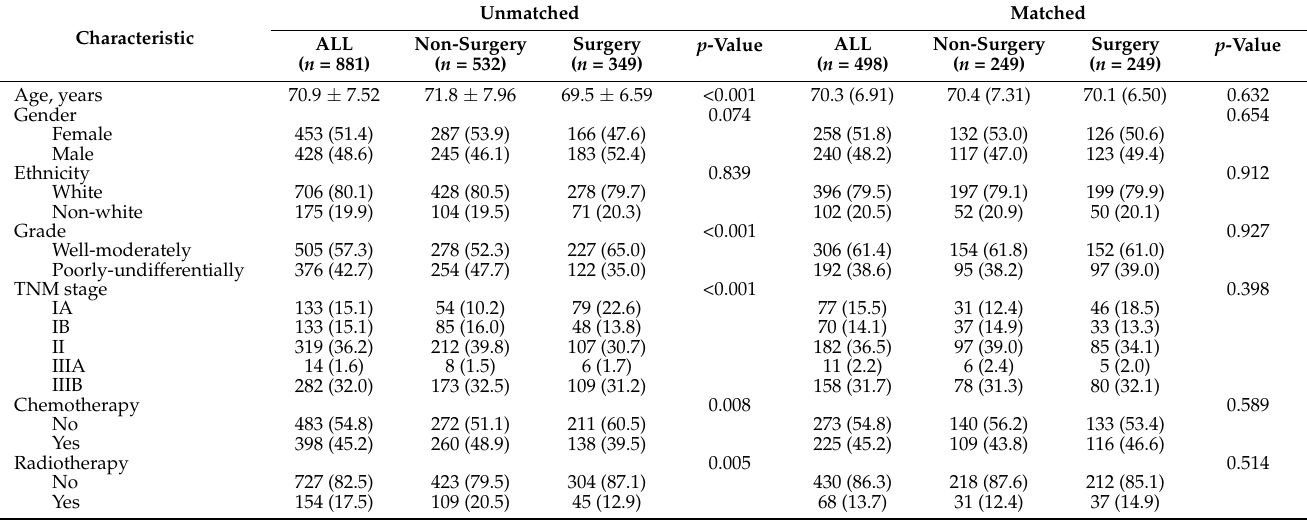
Table 1. Baseline characteristics of ICC patients above 60 years old before and after propensity score